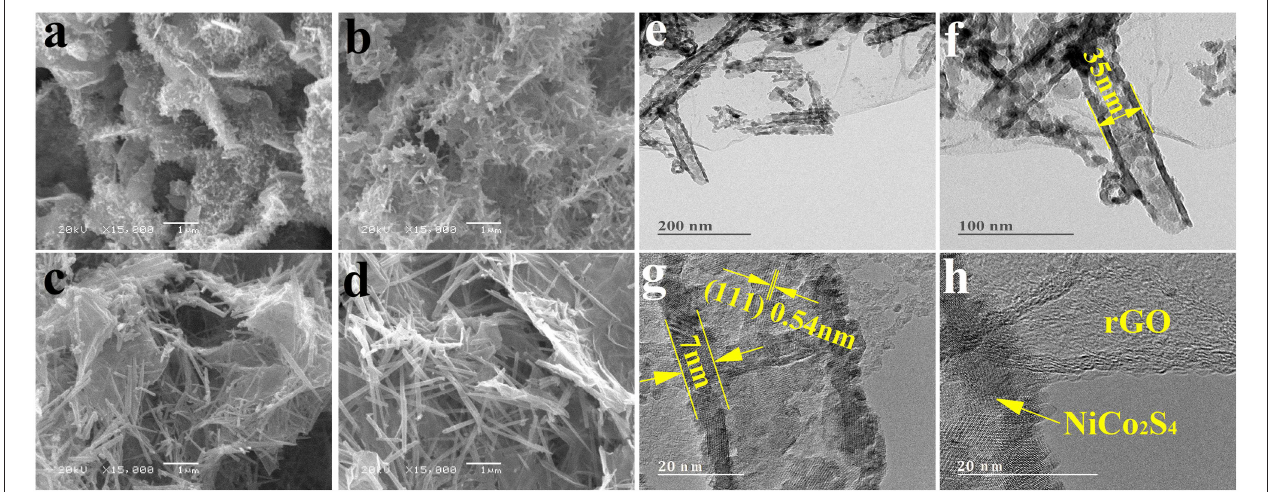
FIGURE 2 | The morphology of Ni x Co y S 4 /rGO composites. (a–d) SEM images of Ni x Co y S 4 /rGO composites; Ni 2.15 Co 1.37 S 4 /rGO (a) , Ni 1.64 Co 2.40 S 4 /rGO (b) , Ni 1.02 Co 2.98 S 4 /rGO (c) , and Ni 0.60 Co 3.60 S 4 /rGO (d) . (e–h) TEM and HRTEM images of Ni 1.64 Co 2.40 S 4 /rGO; TEM images of Ni 1.64 Co 2.40 S 4 /rGO (e,f) ; HRTEM images of Ni 1.64 Co 2.40 S 4 /rGO (g,h) .